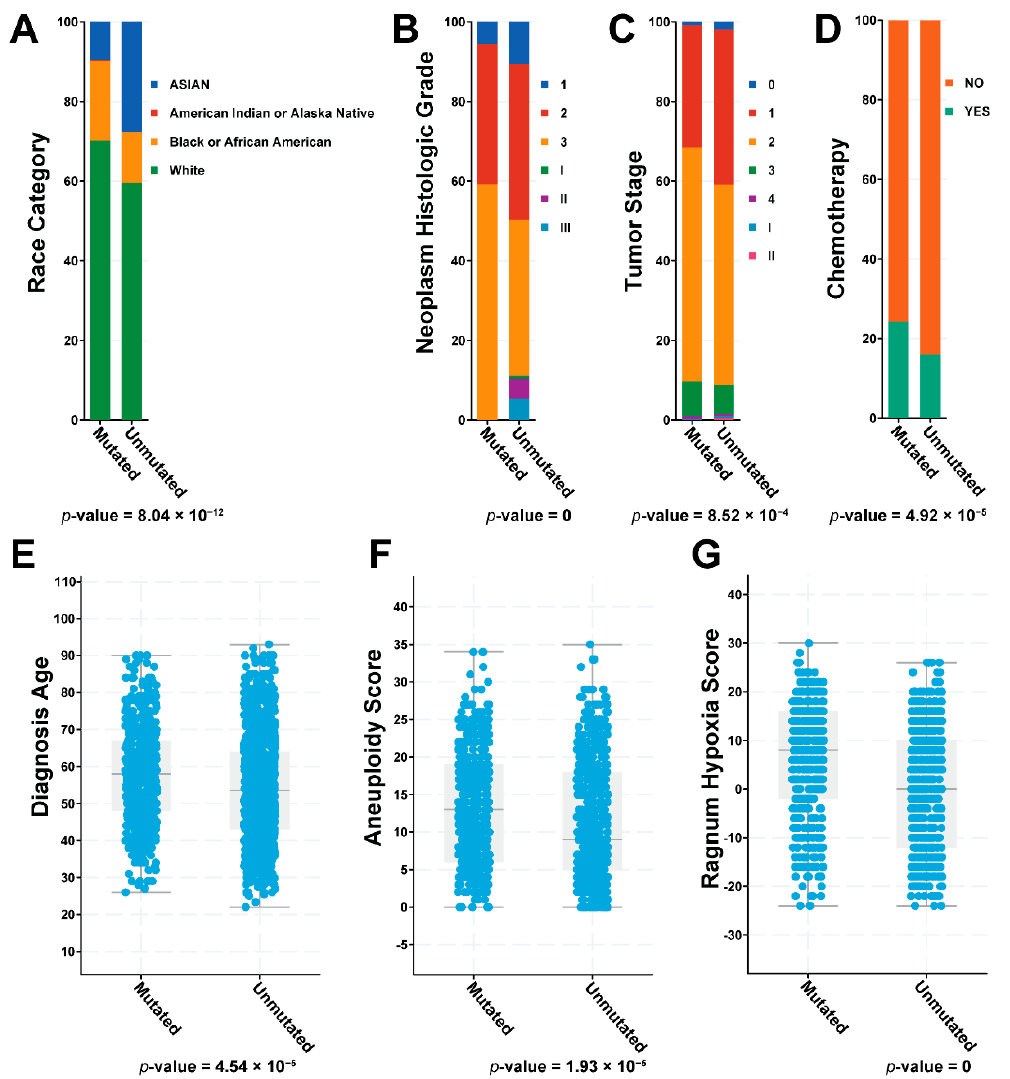
Figure 4. Clinical features summary for the 33 ribosome genes on ( A ) race category; ( B ) neoplasm histological grade; ( C ) tumor stage; ( D ) chemotherapy treatment; ( E ) diagnosis age; ( F ) aneuploidy score; and ( G ) ragnum hypoxia score. The p -values are the statistical tests between patients with or without any genetic mutations on the 33 genes.